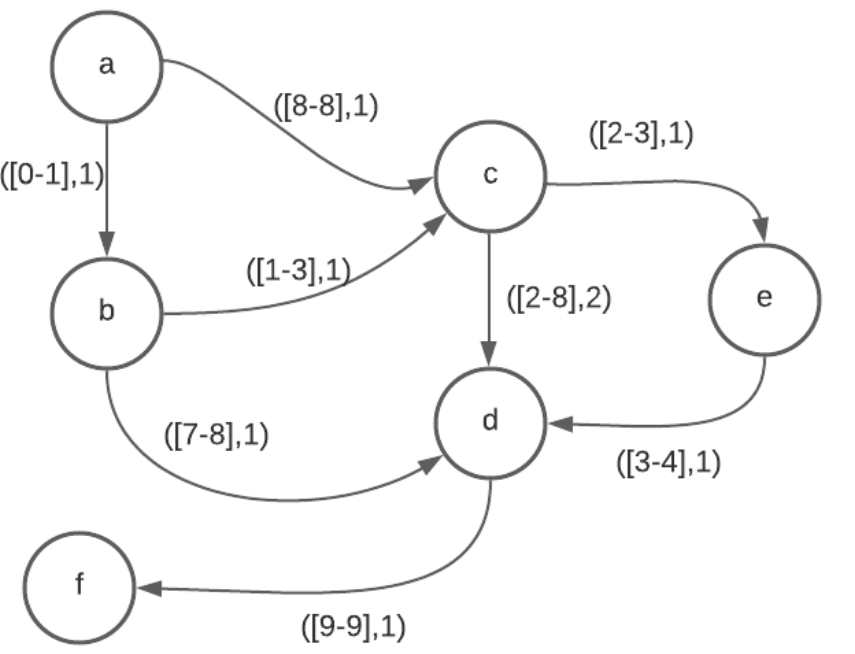
Figure 7. Example mhf paths from vertex a